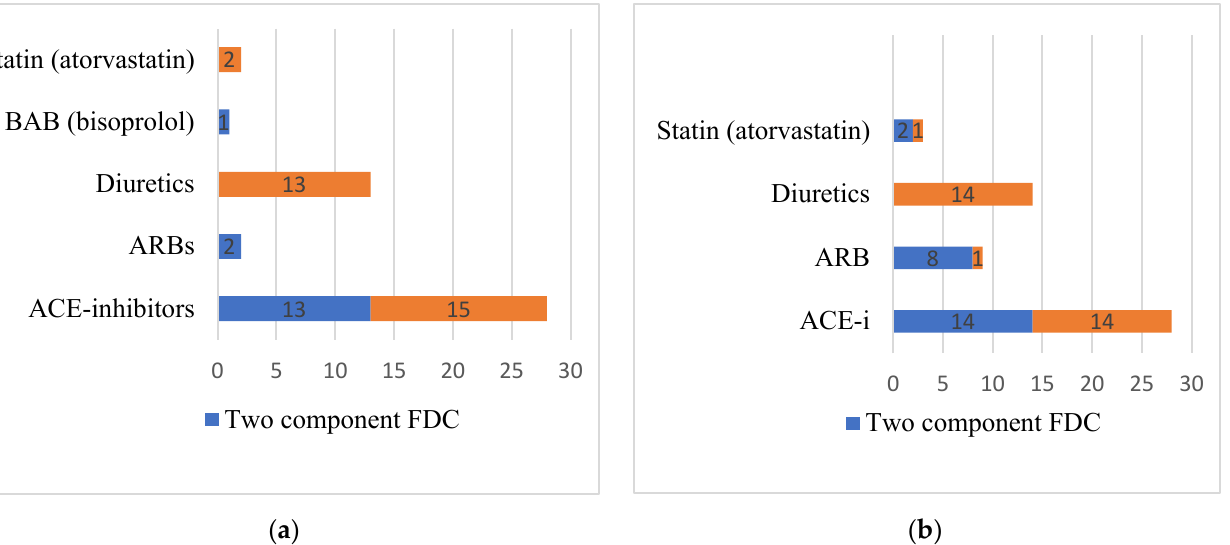
Figure 2. Pharmacological groups used by patients in FDC with the amlodipine. ( a ) Age group <65 years. ( b ) Age group ≥ 65 years.